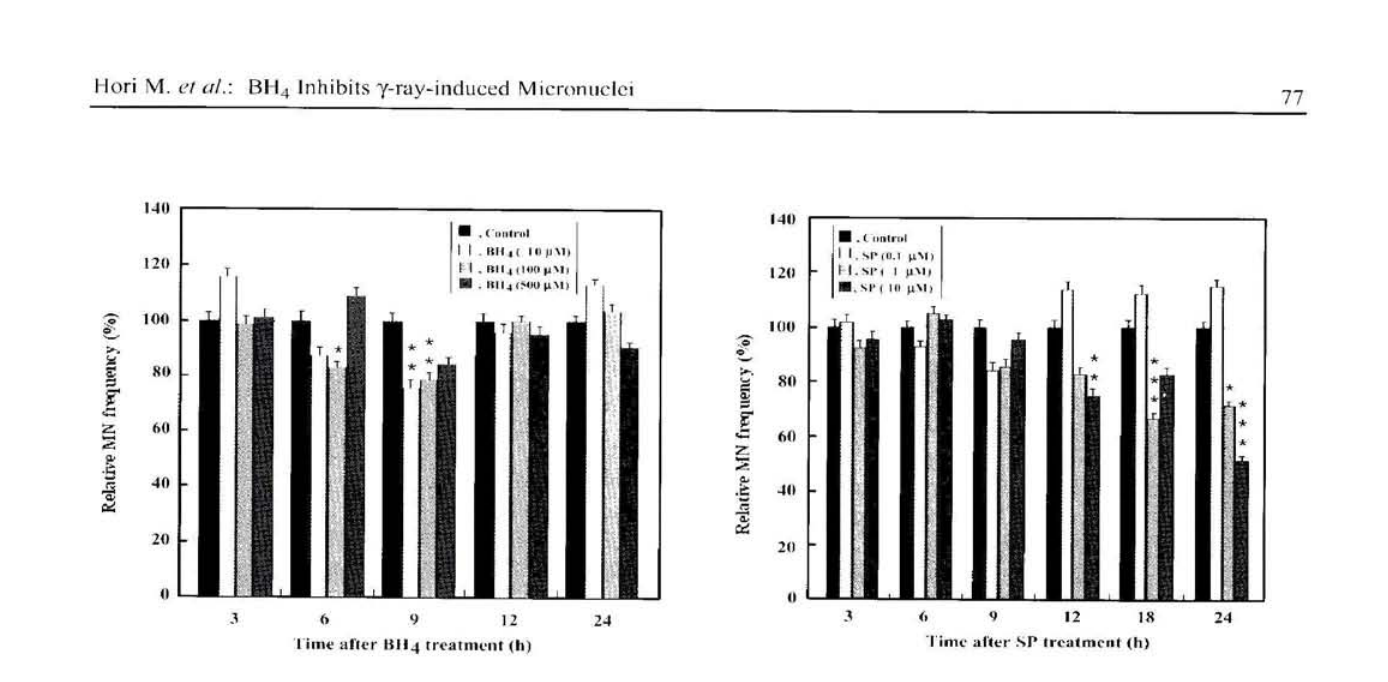
Figure 2. Micronuclcus ( M N) frequency induced by 5 Gy γ-rays at different times after treatment with vari- ous concentrations of 5,6,7,8-tctrahydrobiopterin (BH 4 ) in RAW264.7 cells. RAW264.7 cells were incu- bated with BH4 for 0 to 24 h before irradiation with γ- rays at a dose of 5 Gy. After exposure to γ-rays, the cells were kept for 24 h under normal growth condi- tions before the quantification of micronuclei. Each point indicates the mean ± SE (n-500). The relative MN frequency was calculated with respect to the MN frequency of the group irradiated with 5 Gy γ-rays alone taken as 100% at each time. * and ** , signifi- cantly different from the radiation-alone group at p<0.05 and p<0.01, respectively.